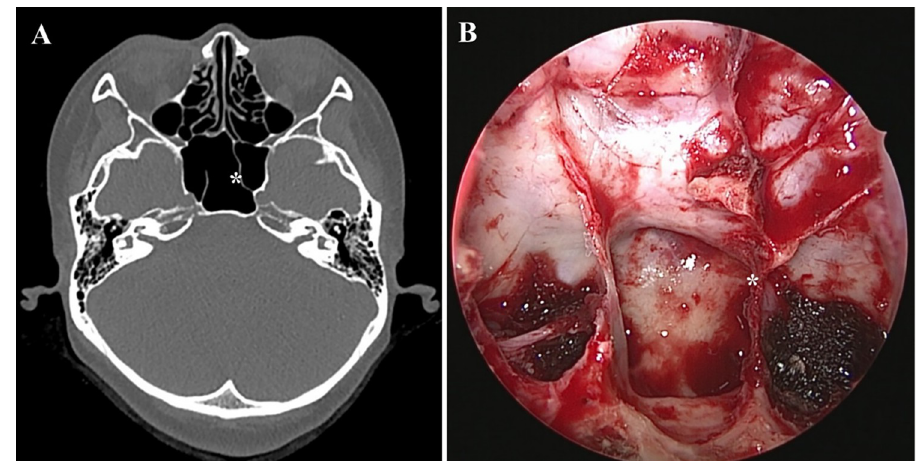
Fig 1. An intersphenoid sinus septum (asterisk) inserted into the paraclival internal carotid artery in a patient with postsellar pneumatization, as revealed by preoperative paranasal sinus computed tomography (A) and during endoscopic endonasal transsphenoidal surgery